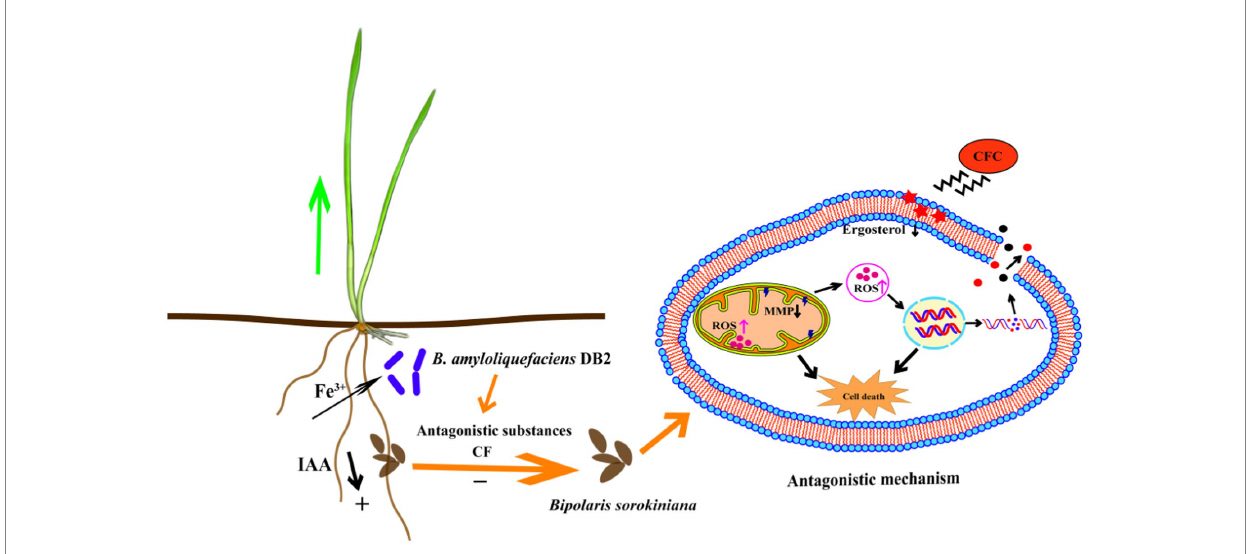
FIGURE 9 Proposed model showing that Bacillus amyloliquefaciens DB2 can promote wheat seedlings growth and underlying mechanisms of antagonistic strain DB2 against Bipolaris